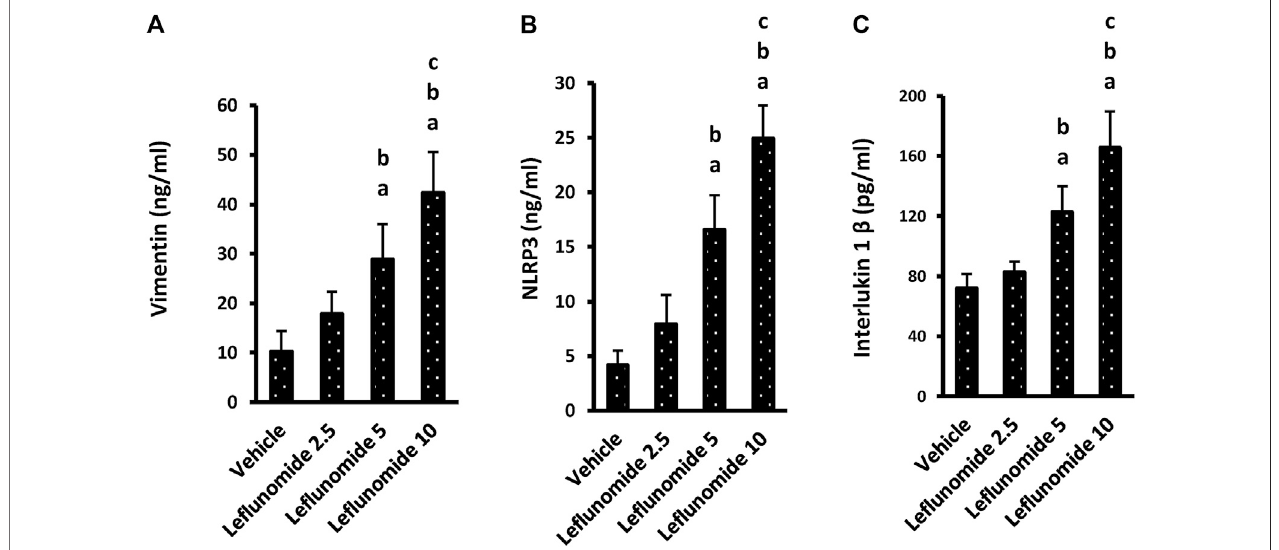
FIGURE9| Thelevelofthein fl ammatorymarkersinlunghomogenates. (A) vimentin, (B) NLRP3 and (C) interlukin-1 β .Column chartrepresenting themeanarea ± SDM, (A) : vs. the vehicle group, (B) : vs. the le fl unomide 2.5 mg per kg group, (C) : vs. the le fl unomide 5 mg per kg group at p < 0.05.